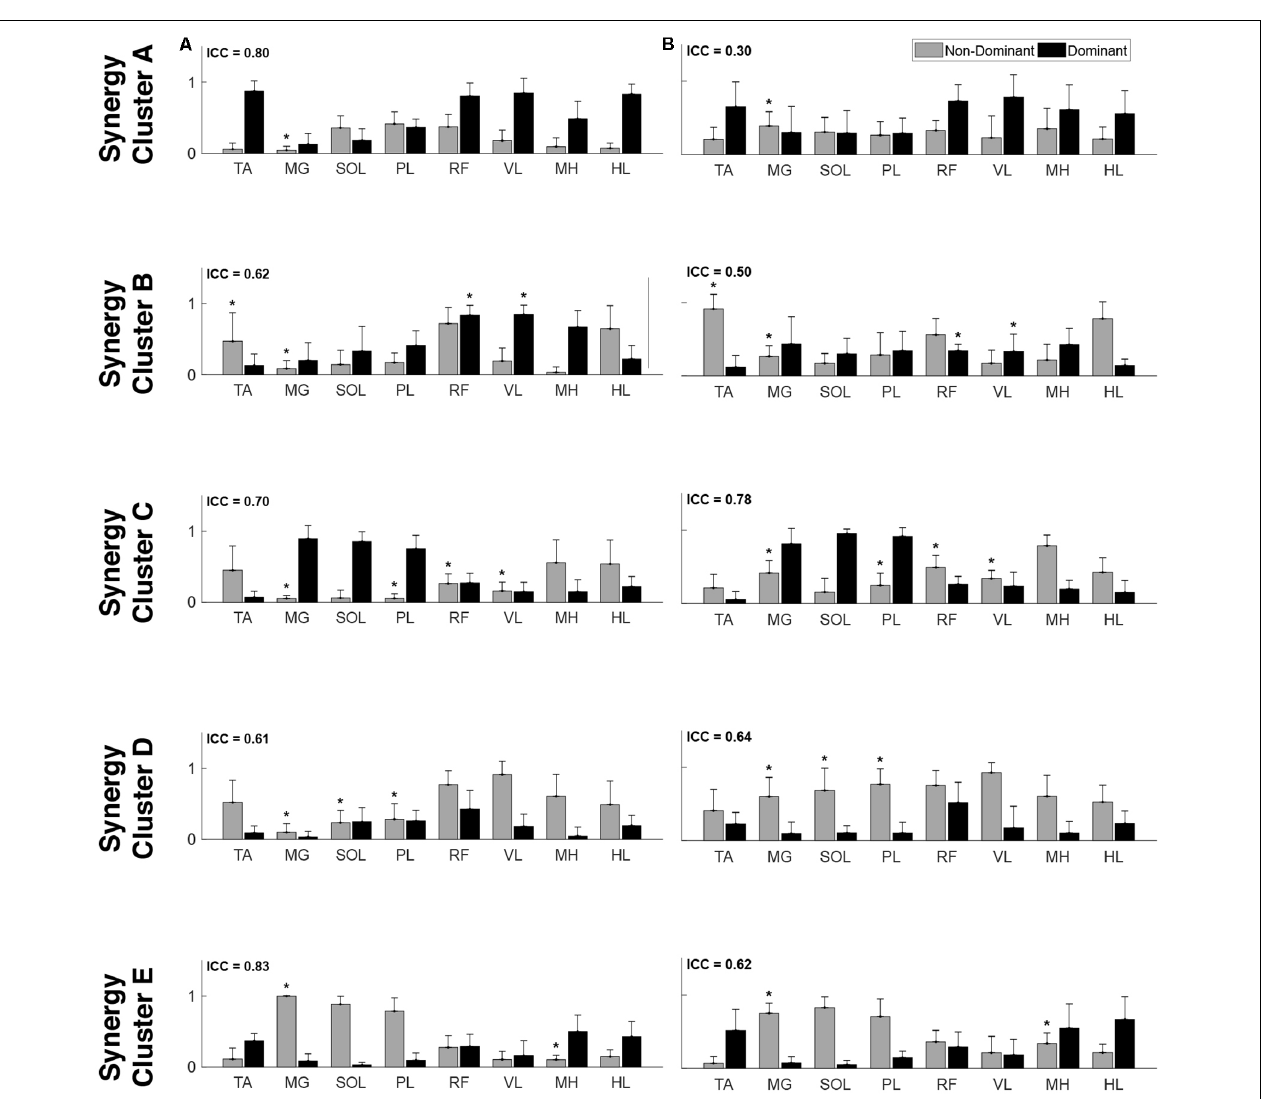
FIGURE 4 | Muscle synergy weightings. Mean (standard deviation) weight coefficients for each synergy cluster in (A) TD and (B) CP. Asterisks ( * ) indicate significant differences between groups for individual muscle weightings, relative to each synergy cluster ( p < 0.01, independent t -test). Mean intraclass correlation coefficients (ICC) are reported in the upper left corner of each